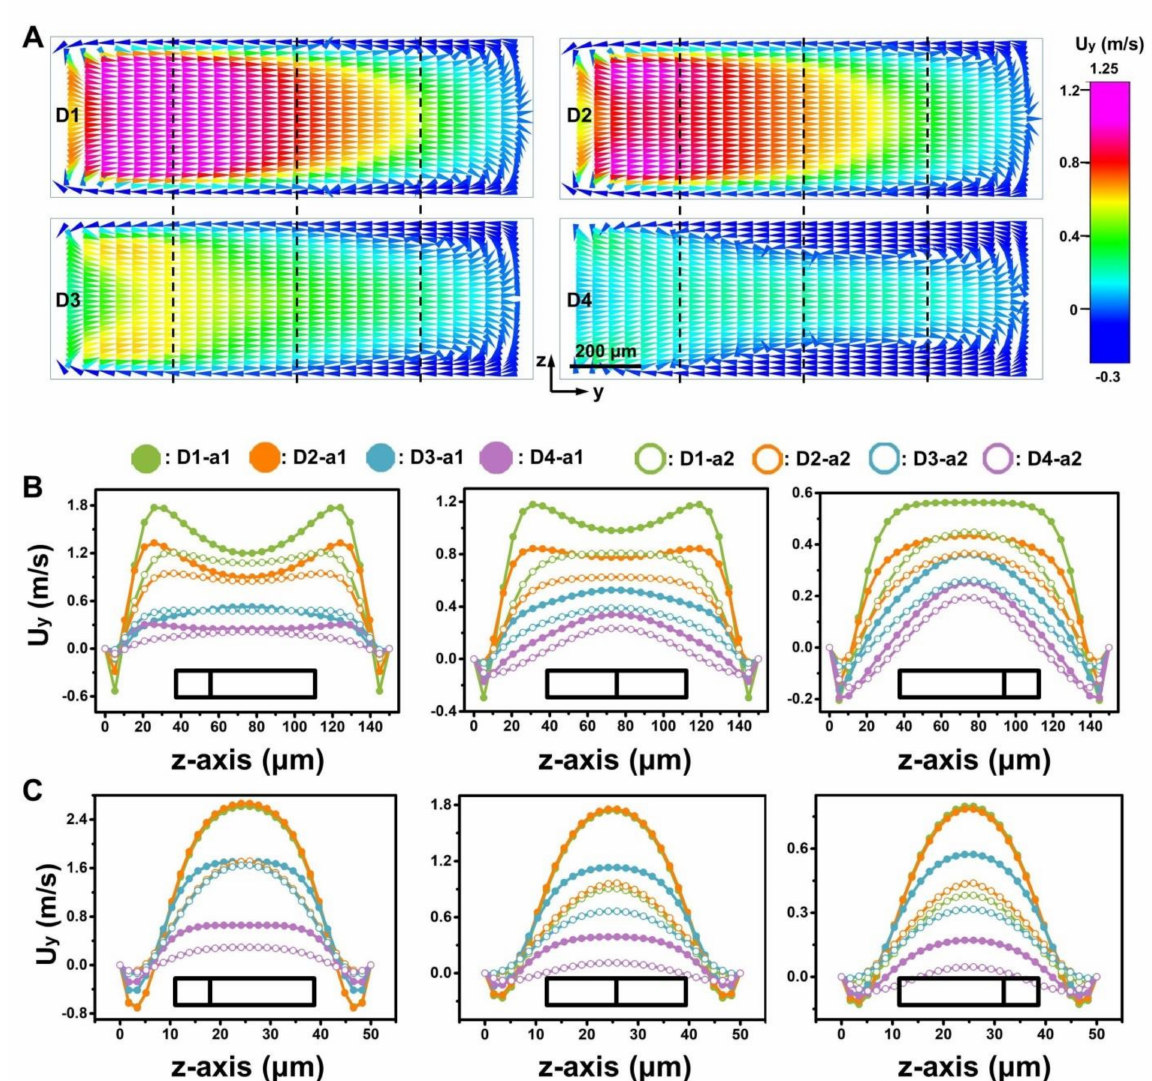
Figure 8. Fluid motion along channel cross sections in narrow regions of the D-channels at a flow rate of 15 mL min − 1 . ( A ) Simulated Dean vortex in the y-axis of a narrow region (NR = 450/900) in different D-channels (D1, D2, D3, D4) with a 150 µ m height. To evaluate the local flow field quantitatively, the section is divided into four parts. ( B , C ) Quantitative study of the y-axis fluid velocity in each narrow region (NR = 270/900, 450/900, 630/900, 810/900) of different D-channels (D1, D2, D3, D4) with 150 µ m ( B ) and 50 µ m ( C ) height. a1, a2, a3, and a4 represent 270, 450, 630, and 810 µ m widths of the narrow regions in Figure 1A